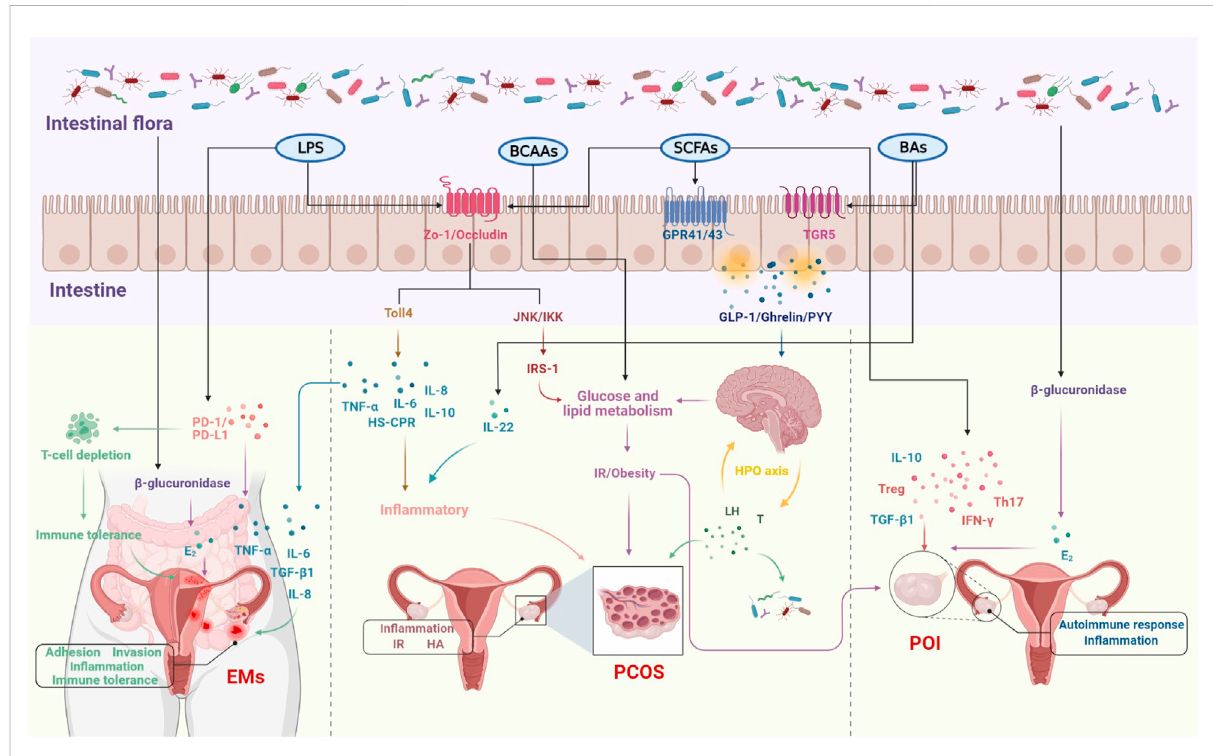
FIGURE 1 The molecular mechanisms of intestinal fl ora involved in the development of female reproductive